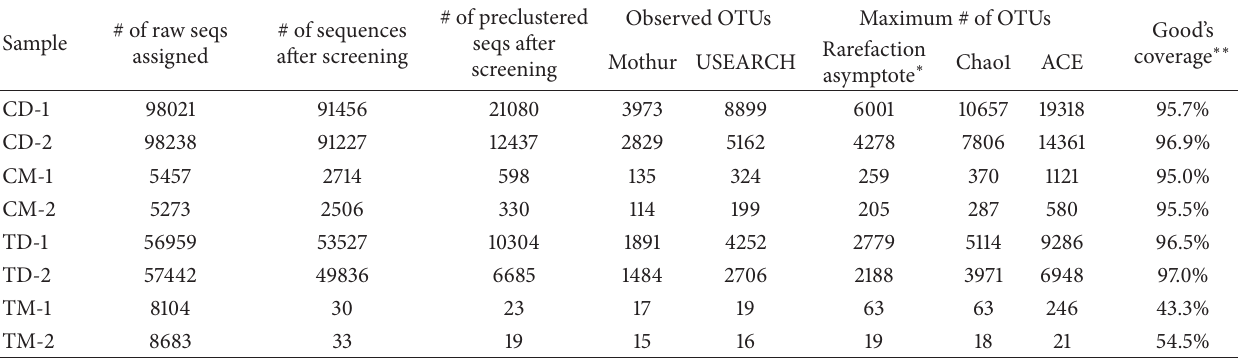
Table 2: Summary of the 454 pyrosequencing